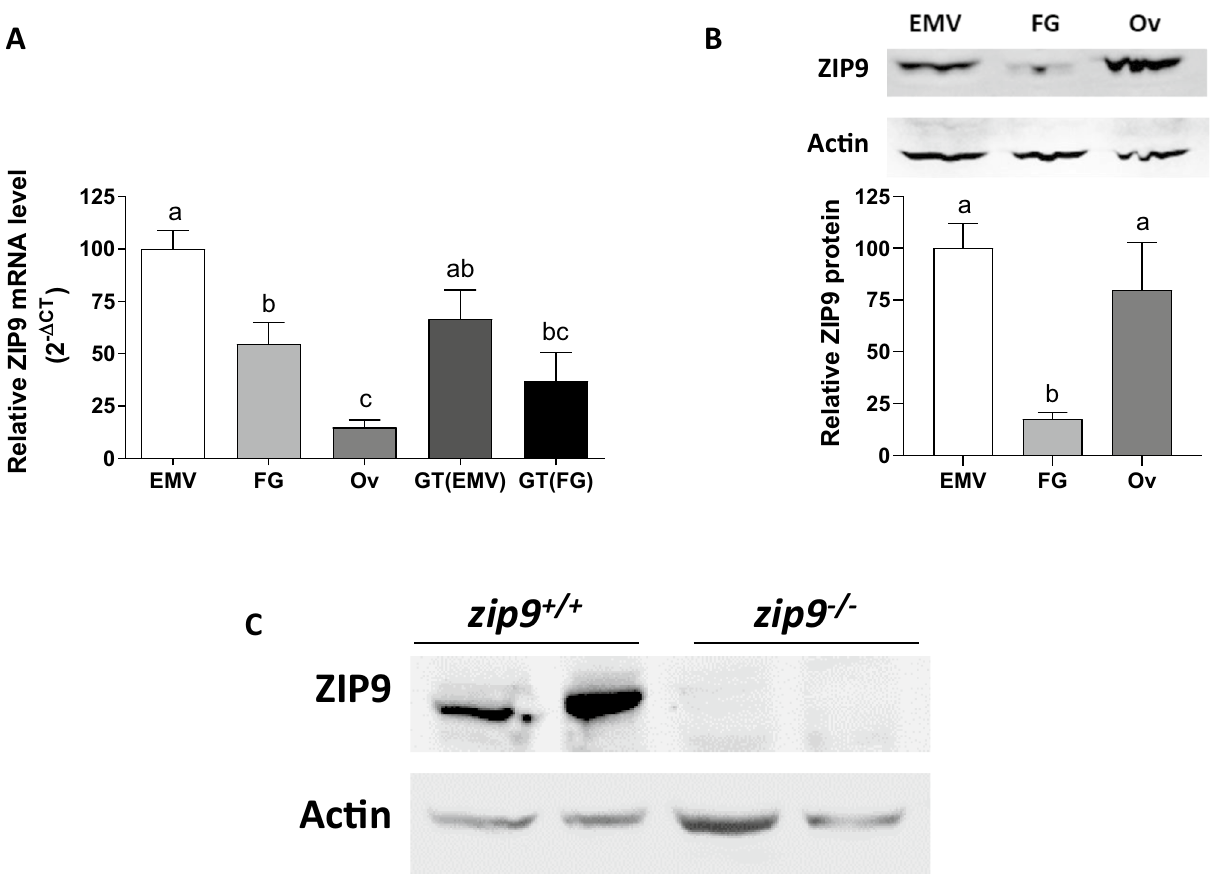
Figure 1. ZIP9 expression in the zebrafish ovary. (A) mRNA expression of ZIP9 in different stage wildtype oocytes and follicle cells (n = 4–6). (B, C) Western blot analysis of ZIP9 protein expression on the plasma membrane of different stage wildtype oocytes/eggs (B) and the plasma membrane fraction of wildtype and zip9 -/- fish ovaries (C) (n = 3–4). All data represents means ± SEM. Significance was determined by one-way ANOVA with Bonferroni multiple comparison post-test. Different letters indicate significant differences between treatment groups in the post hoc test (P < 0.05). EMV early-mid vitellogenic oocytes, FG full grown oocytes, Ov ovulated eggs, GT ( EMV ) granulosa/theca cells from early-mid vitellogenic follicles, GT ( FG ) granulosa/theca cells from full grown